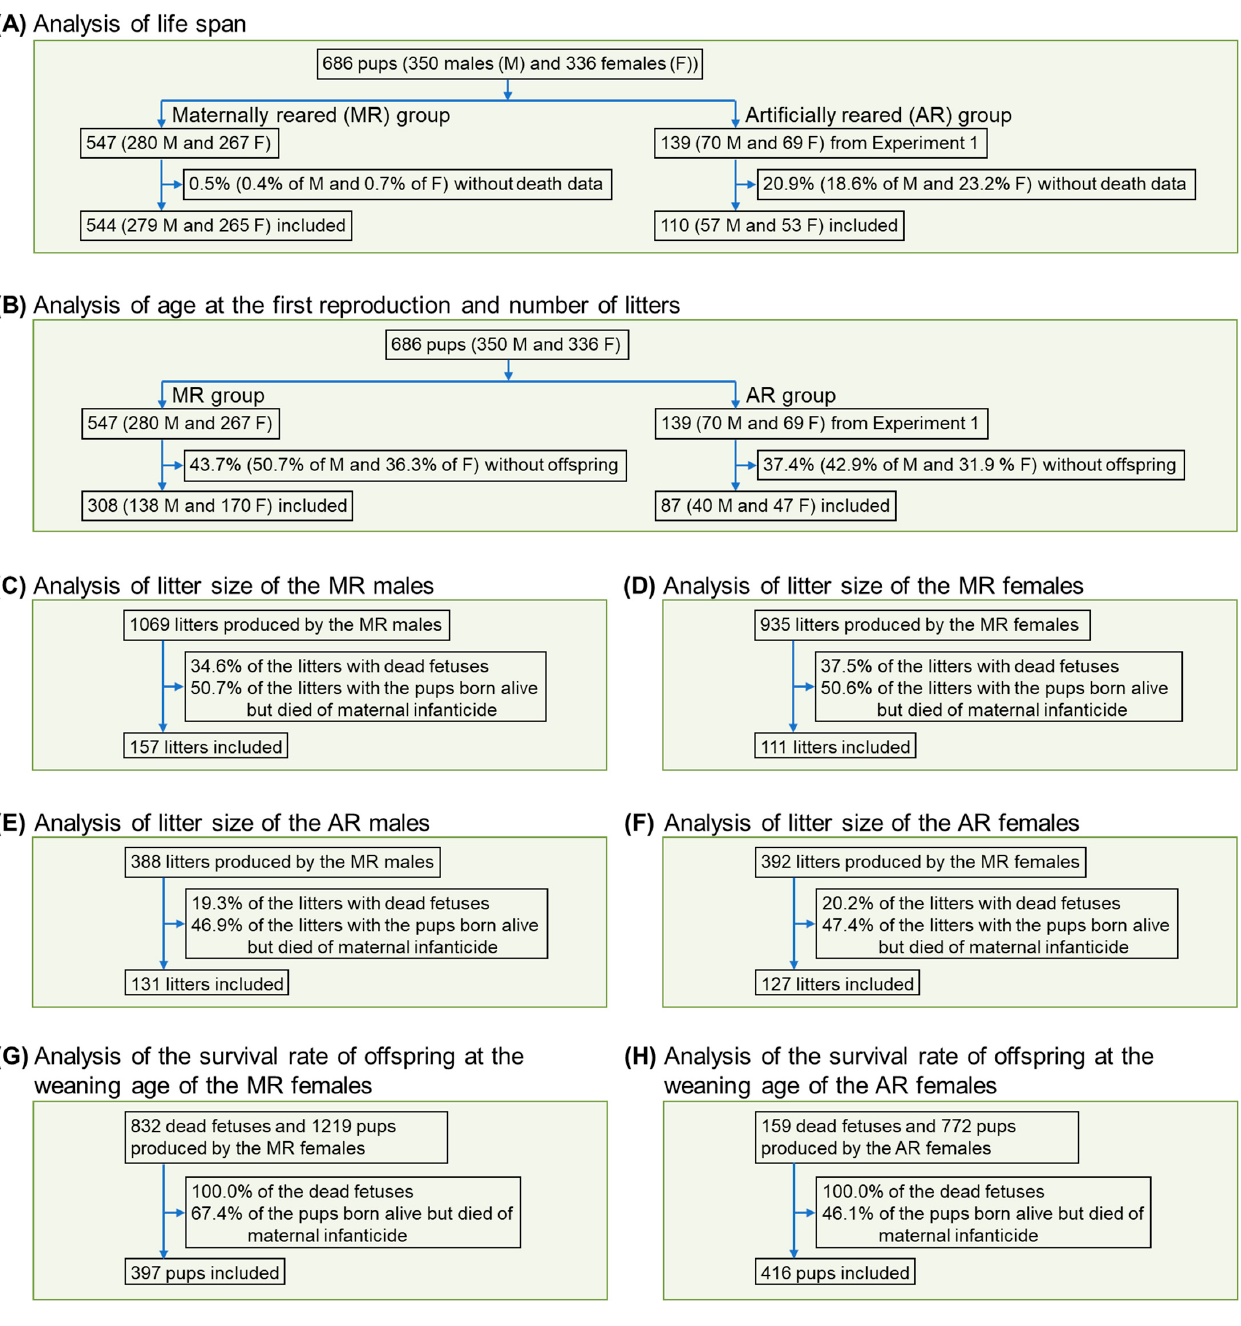
Figure 2. Enrollment of the F 1 generation tree shrews in Experiment 2.